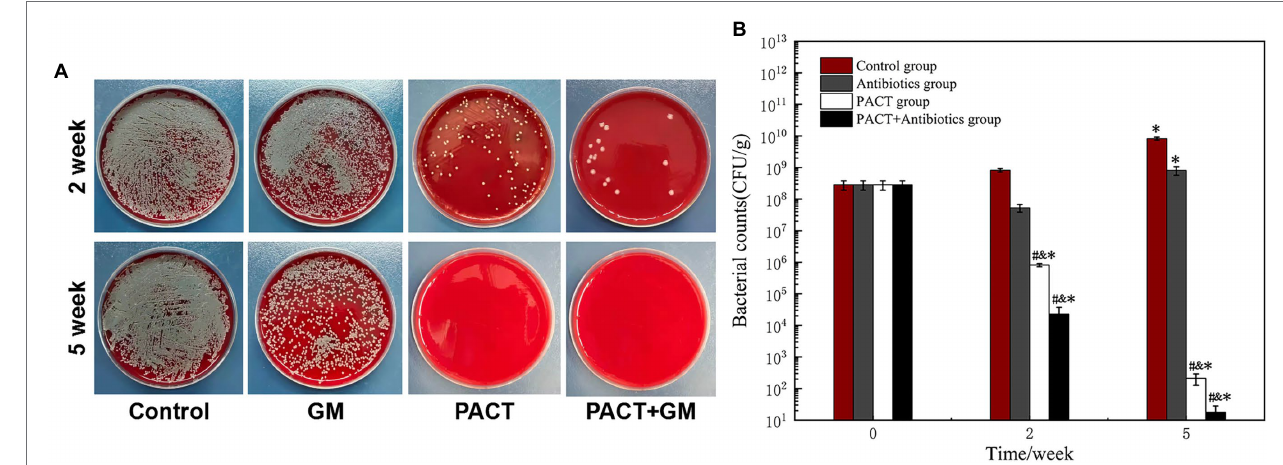
FIGURE 4 | Results of bacterial culture of the bone marrow tissue from the bone marrow cavity. (A) Bacterial colonies from the bone marrow tissue of each group diluted to 1 × 10 − 4 ; (B) histogram comparing the numbers of bacterial colonies counted for each group. * p < 0.05 indicates a statistically significant difference compared with before treatment, # p < 0.05 indicates a statistically significant difference compared with the control group, and & p < 0.05 indicates a statistically significant difference compared with the antibiotic